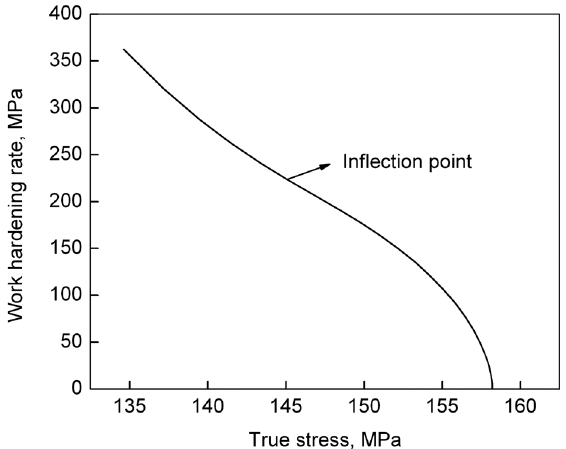
Fig. 2: Curve of work hardening rate versus true stress at 1000 °C and 0.1 s − 1 .